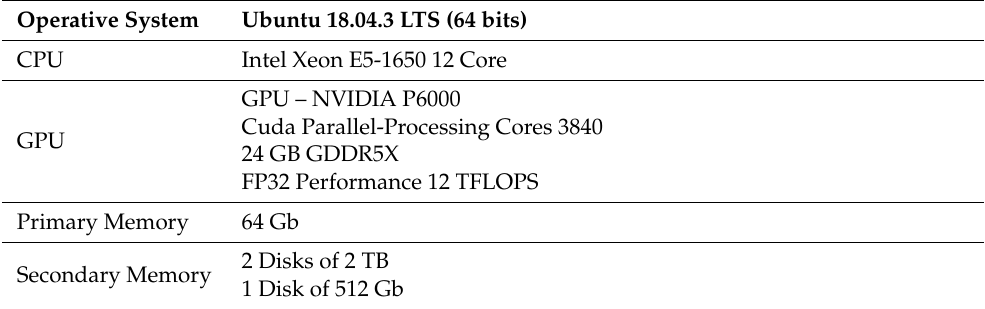
Table 1. Workstation